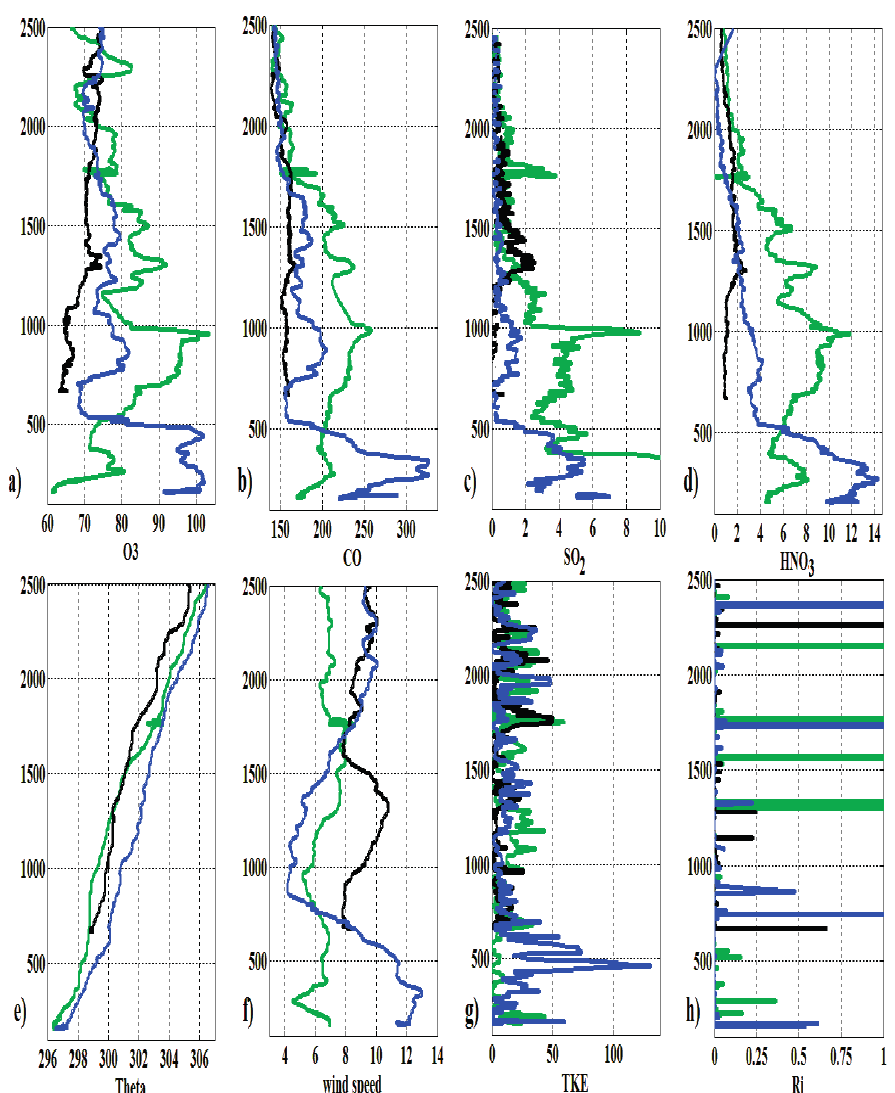
Figure 3. Vertical profiles of primary trace gas species and physical parameters observed near the NYC source region on 7/20. Shown are mixing ratios for ( a ) O ( d ) HNO (all in ppbv) along with ( e ) theta (K) ( f ) horizontal wind speed (m/s); 3 ( g ) turbulent kinetic energy (J/kg); and ( h ) Richardson number. Black lines correspond to the observations directly over the NYC region at 18:30 UTC; green lines designate the evolution observed 130 km downwind of NYC at 19:20 UTC; and Blue lines mark observations 250 km downwind at 20:00